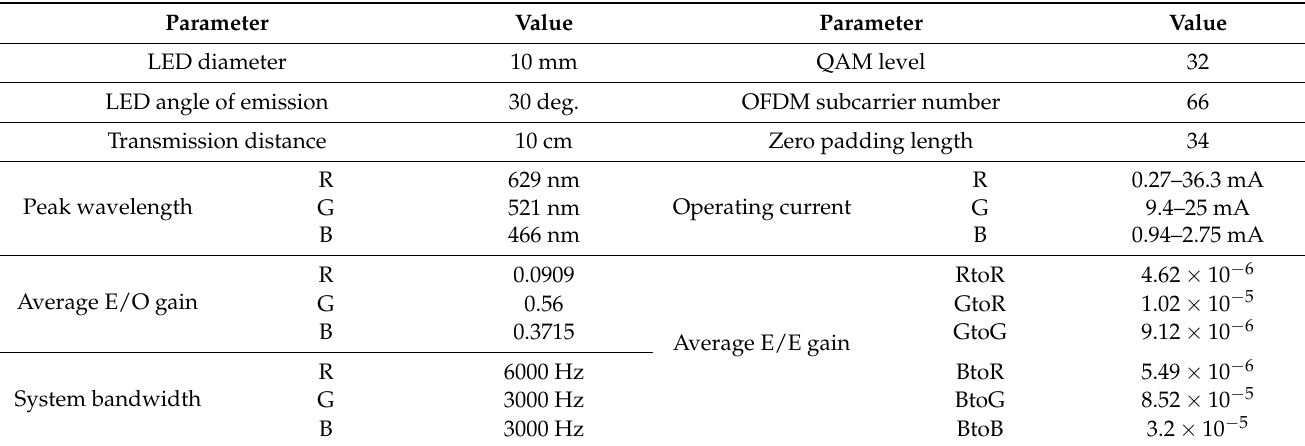
Figure 8. Experimental setup of the 3 × 3 MIMO LED-to-LED communication system using RGB LEDs. Table 1. Experimental conditions in 3 × 3 MIMO LED-to-LED communication